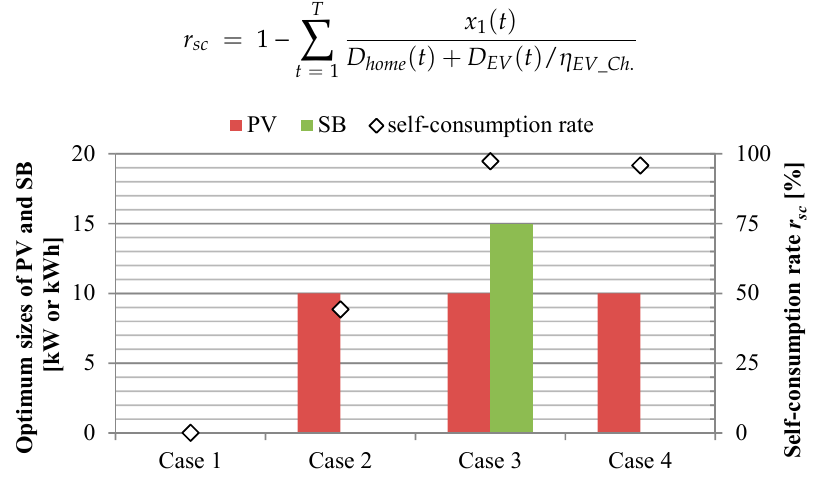
Figure 13. Self-consumption rate and optimum sizes of PV and SB.